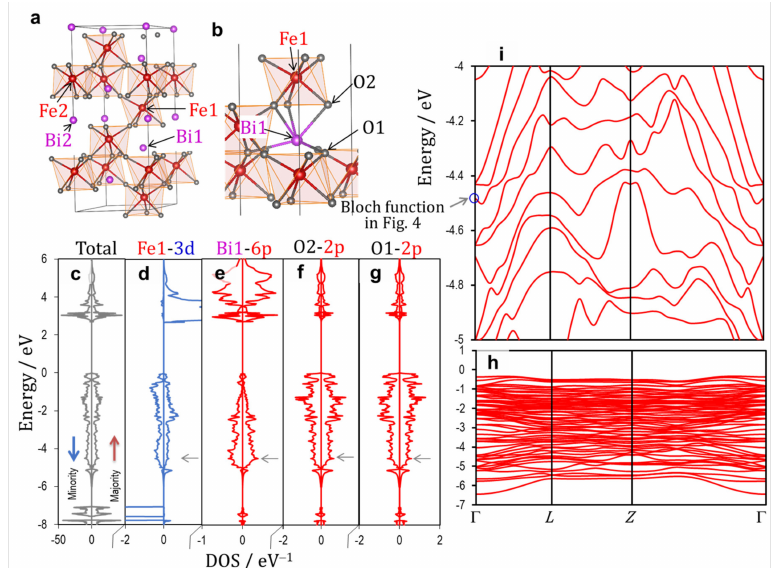
Figure 3. Crystal structures ( a , b ), electronic density of states (DOS) ( c – g ), and band structures (of the majority spin band) in the valence band ( h , i ) of the rhombohedral BiFeO 3 ( x = 0). The wavefunction of the band shown in blue circle in ( i ) is displayed in Figure 4. The up (red) and down (blue) arrows in ( c ) denote the majority and minority spin bands, respectively. The horizontal arrows (gray) in ( c – g ) correspond to the energy level of the blue circle in ( i ).